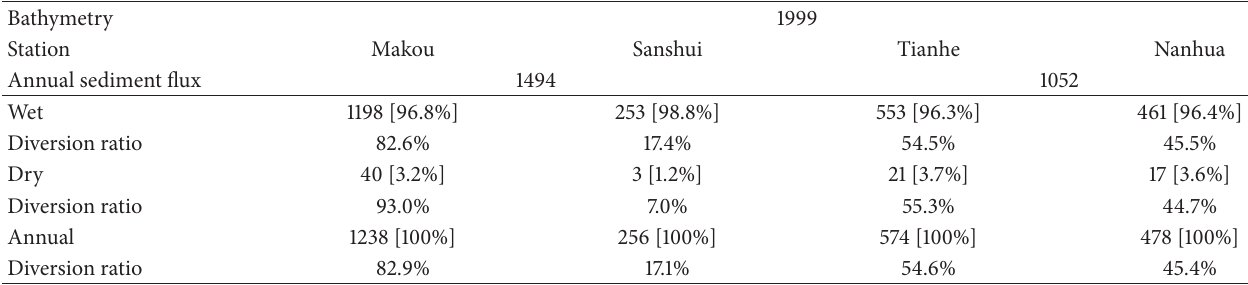
Table 3: The suspended sediment flux and the diversion ratio at the two main joints in the Pearl River network: (a) Makou and Sanshui and (b) Tianhe and Nanhua (unit: × 10 4